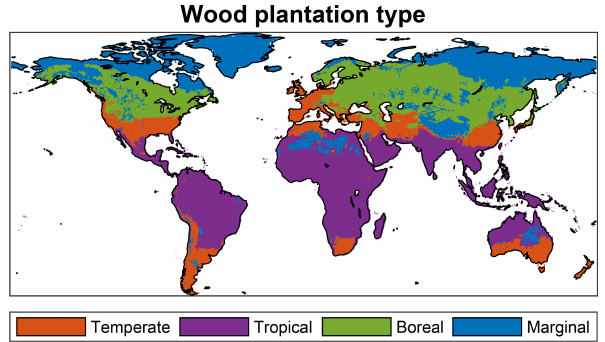
Figure 6. Spatial distribution of the different forest plantation func- tional types resulting from the bioclimatic limits. In marginal re- gions, no trees are simulated, but grass may be